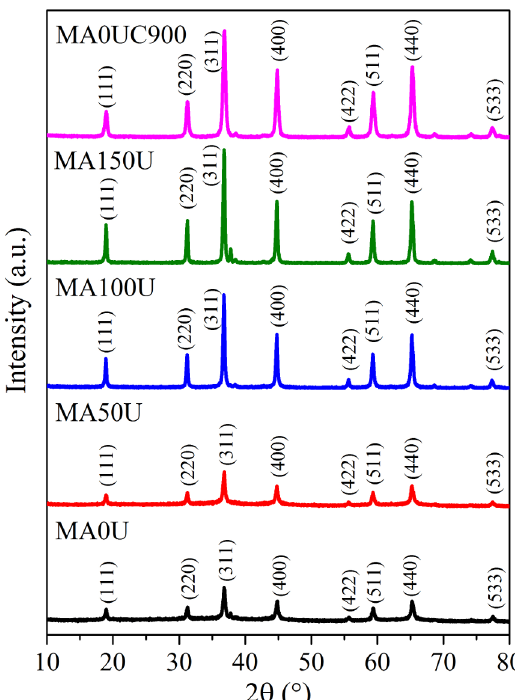
Figure 3. XRD of the samples obtained by using distinct quantities of urea during the synthesis. From Fig. 3 it is also possible to note that, when no excess urea is used in the synthesis (MA0U), a less crystalline material is obtained, so that more defined and more intense peaks are observed after the calcination of the solid at 900 ºC (MA0UC900). However, the spinel prepared from the combustion using 150% of urea excess (MA150U) showed a diffraction pattern corresponding to a material with higher crystallinity, even without realize the drying or calcination steps after the reaction in the